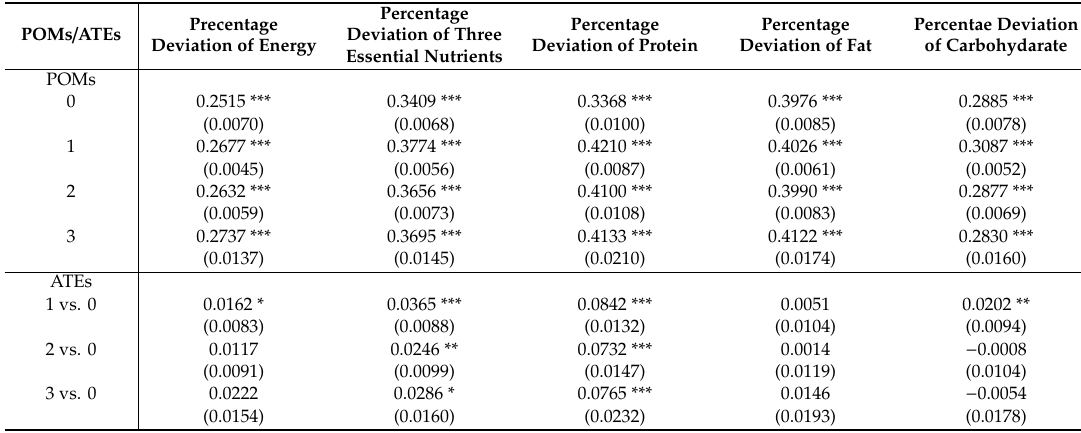
Table 6. The average treatment e ff ects on energy and macronutrients balance.